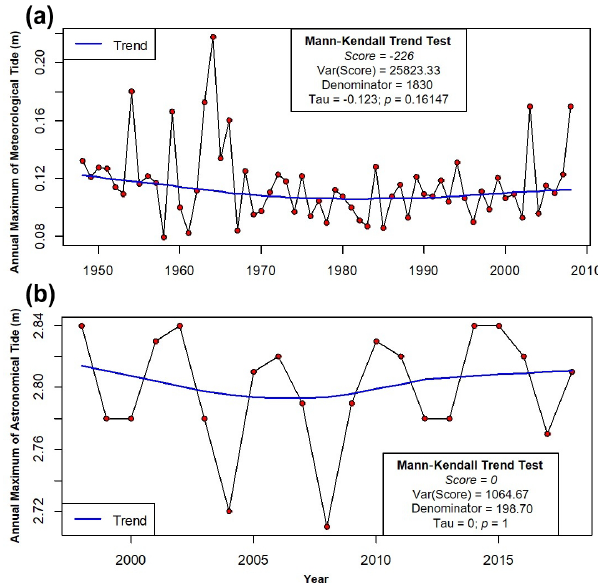
Figure 4. Annual tide maximum level temporal series: (a) meteoro- logical tide and (b) astronomical